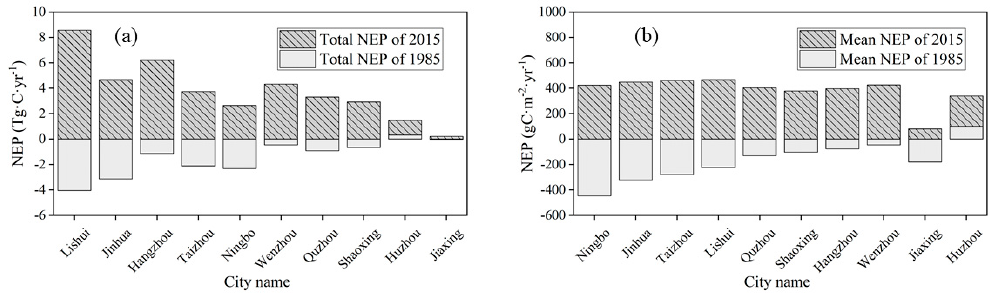
Figure 8. ( a ) Total NEP changes and ( b ) average NEP changes in different cities of Zhejiang Province from 1985 to 2015.